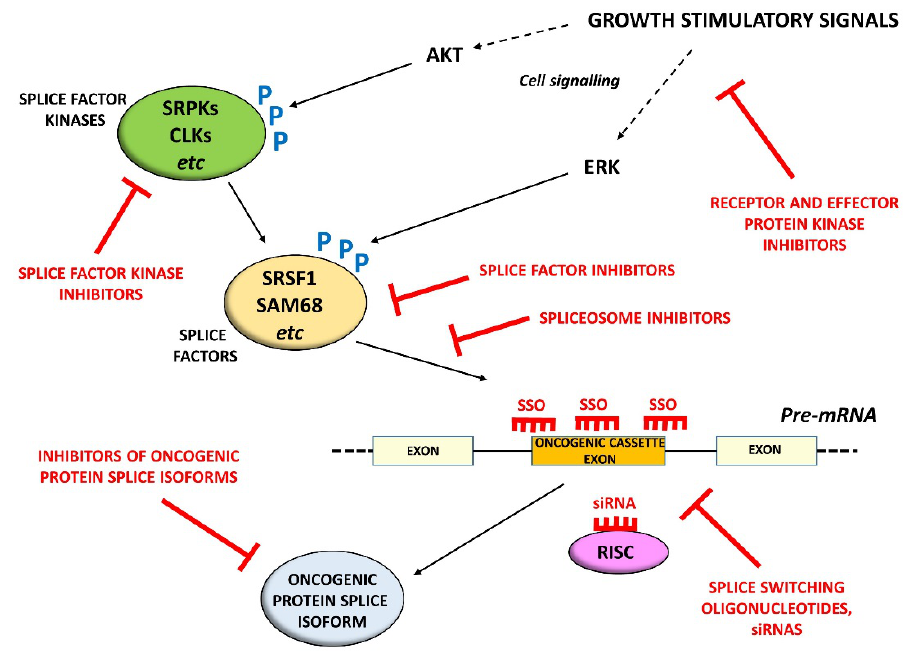
Figure 1. Different approaches to the in vivo modification of splicing of cancer-specific isoforms. Growth stimulatory signals that activate splice factor kinases through AKT or splice factors directly through ERK can be inhibited; splice factor kinases, splice factors or components of the spliceosome can also be targeted directly. At the RNA level, pre-mRNA splicing can be modified with splice switching oligonucleotides (SSOs), and specific mRNA isoforms can be targeted with siRNAs. At the protein level, drugs can also be targeted at specific isoforms.